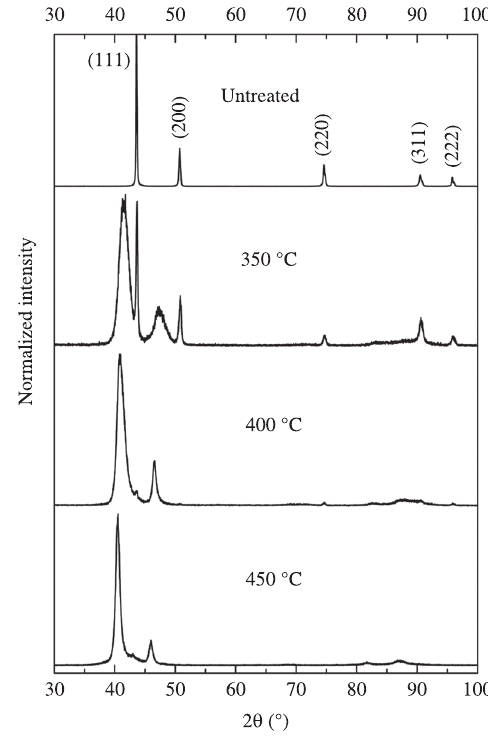
Figure 5. Zoom of the (111) reflection of samples nitrided at different temperatures for (a) 3h and (b)